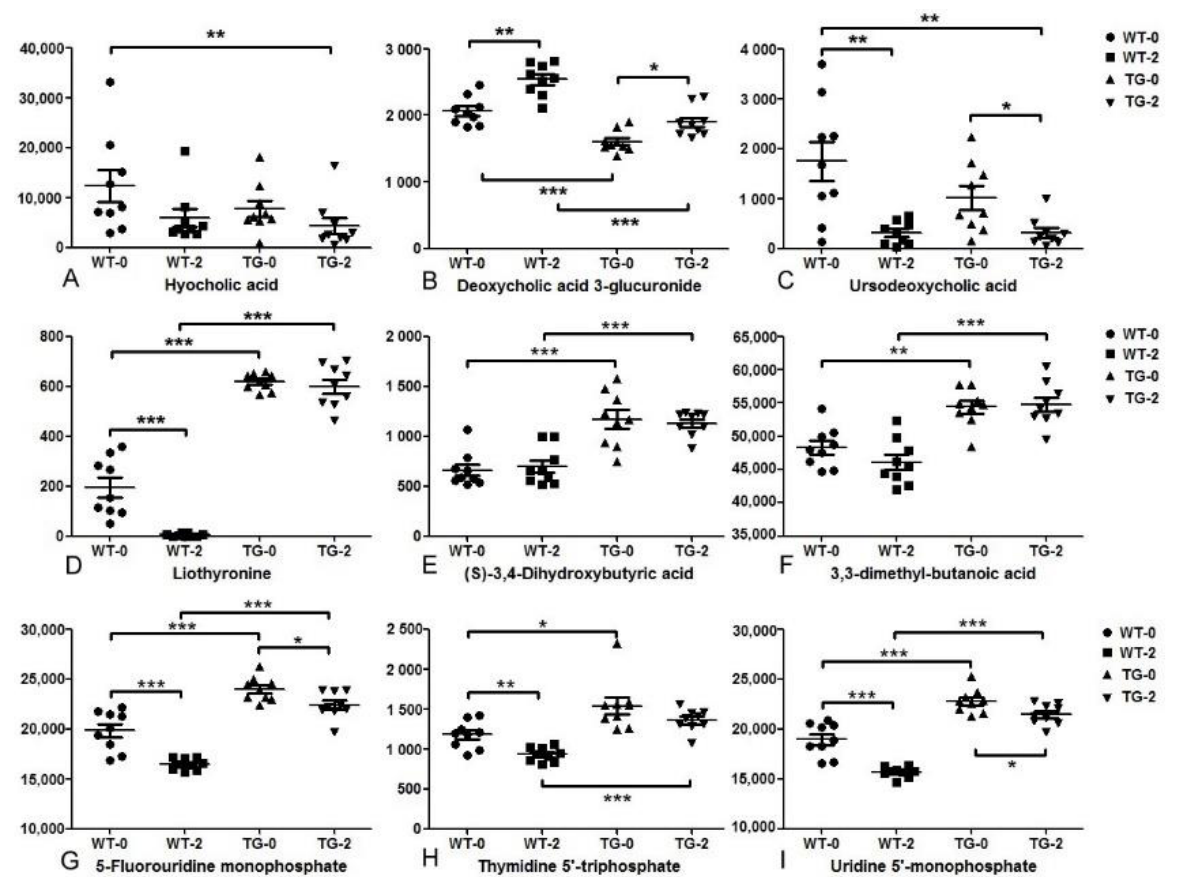
Figure 6. The metabolites and lipids that significantly altered by transgenic effect. ( A – C ) for bile acids, ( D ) for liothyronine, ( E – F ) for butyric acid derivatives, ( G – I ) for nucleotides. * adj. p < 0.05, ** adj. p < 0.01, *** adj. p < 0.001.